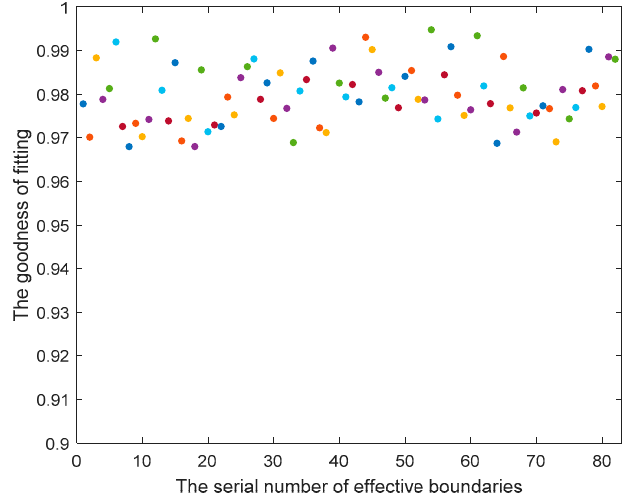
Figure 4. The R 2 value of goodness of fitting of each effective boundary.